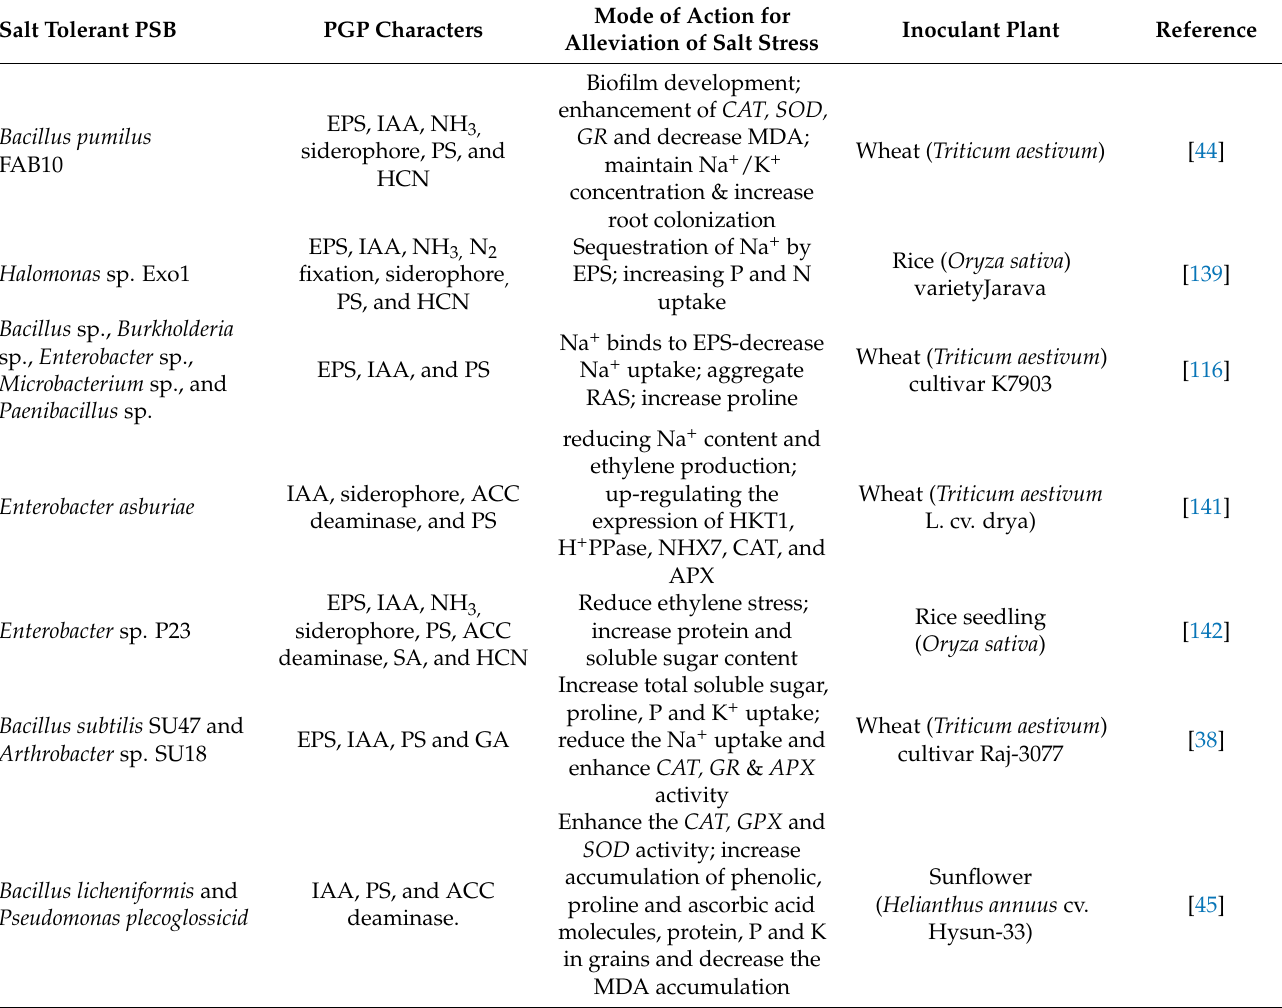
Table 2. List of salt -tolerant PSB and their possible mechanism of salt alleviation in diverse plants and crops. Mode of Action for Salt Tolerant PSB PGP Characters Inoculant Plant Alleviation of Salt Stress